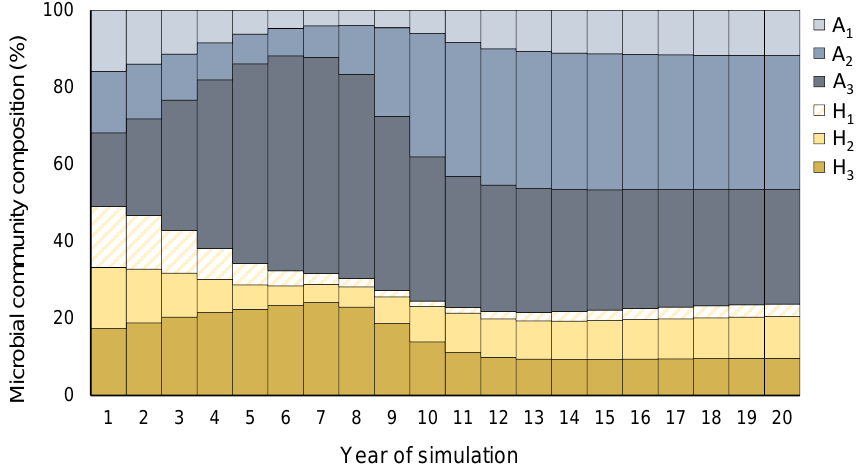
Figure 12. Evolution of the microbial community composition in model output optimised from the Damma Glacier, Switzerland, over the first 20 years of soil